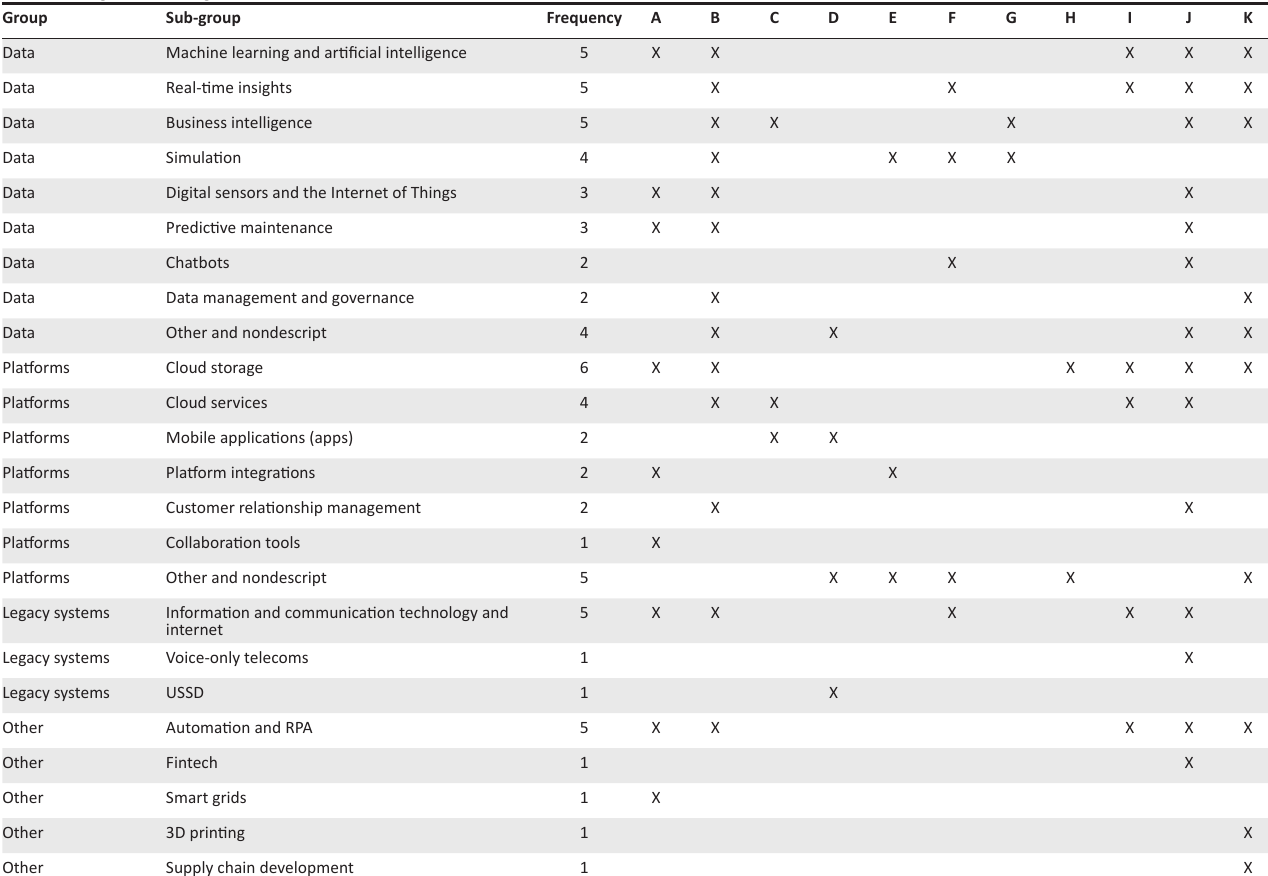
Table B-1: Digital